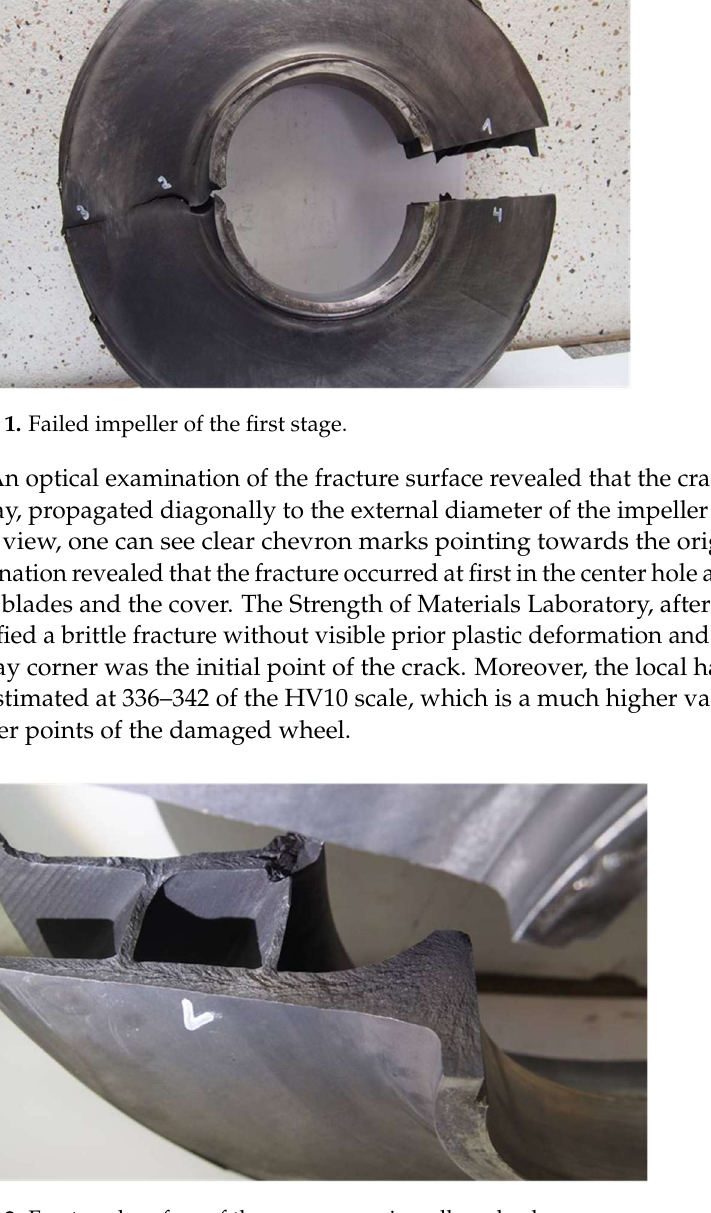
Figure 2. Fractured surface of the compressor impeller wheel.